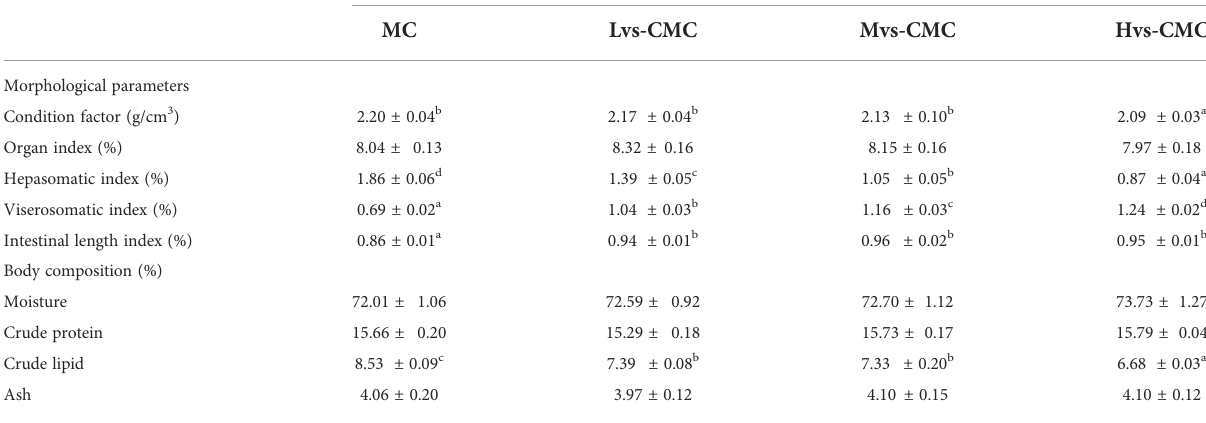
TABLE 3 Effects of increasing dietary viscosity on the morphological parameters and body composition of juvenile largemouth bass. Item